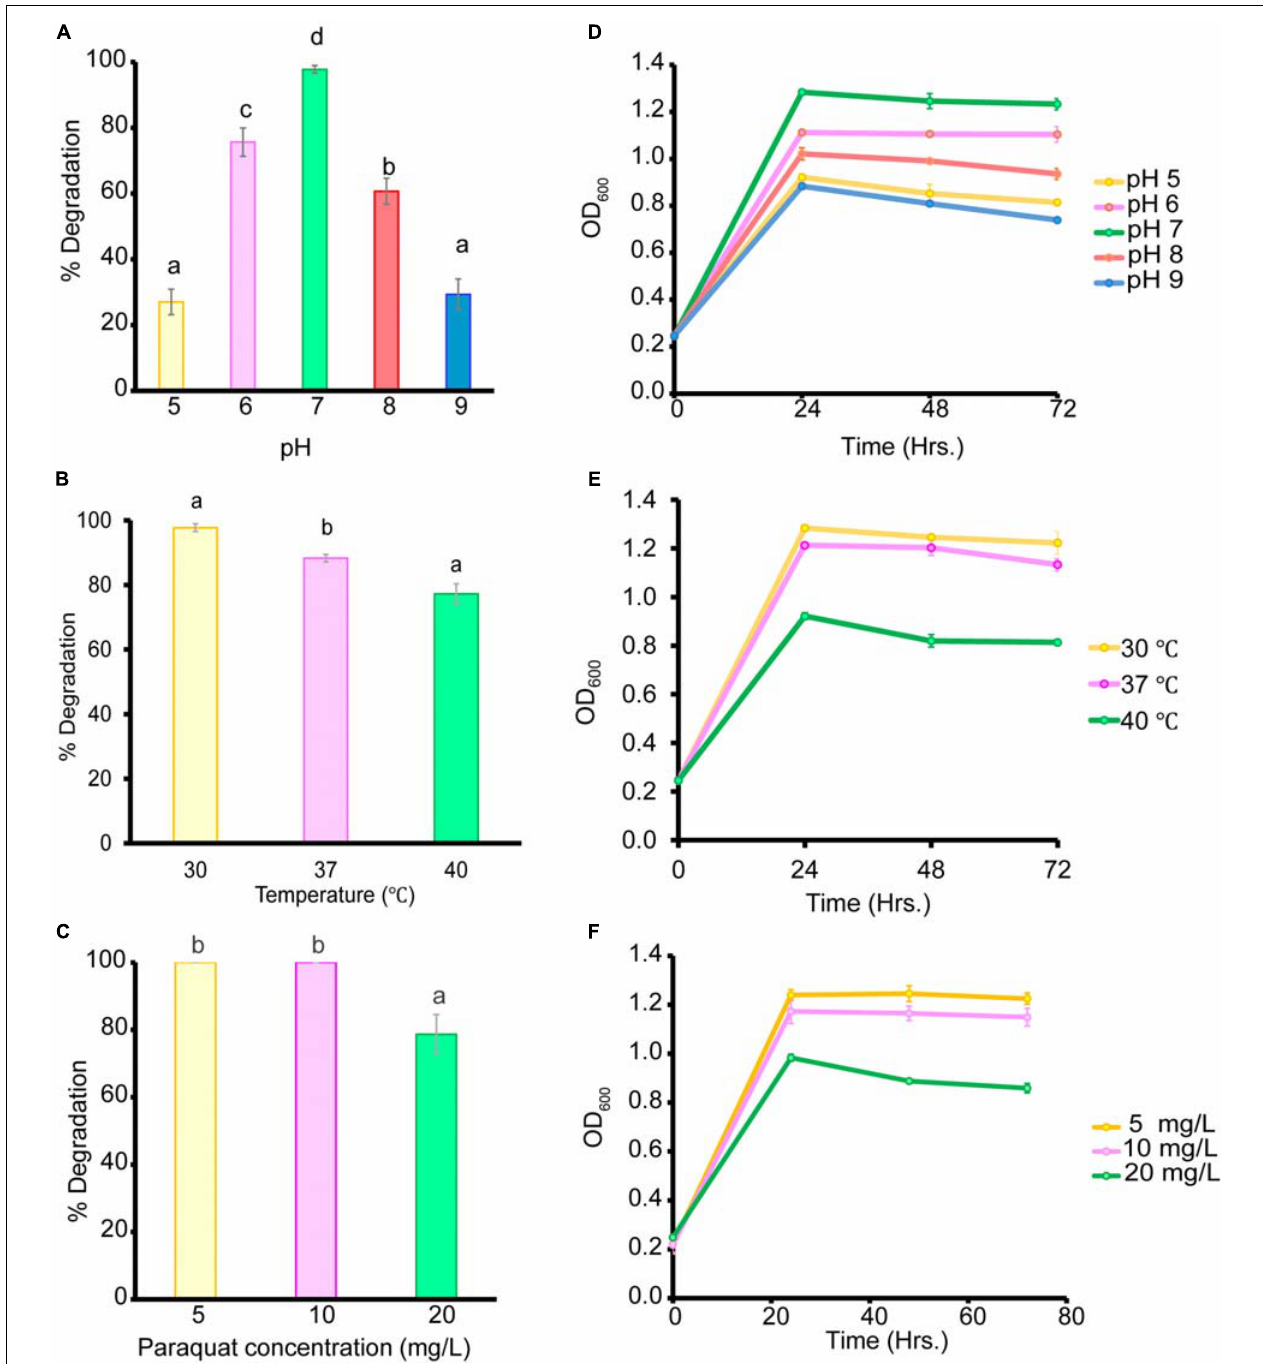
FIGURE 4 | Effect of initial pH on paraquat degradation (A) and growth of bacteria (D) , cultivation temperature on paraquat degradation (B) , and growth of bacteria (E) and initial paraquat concentration on paraquat degradation (C) and growth of bacteria (F) .